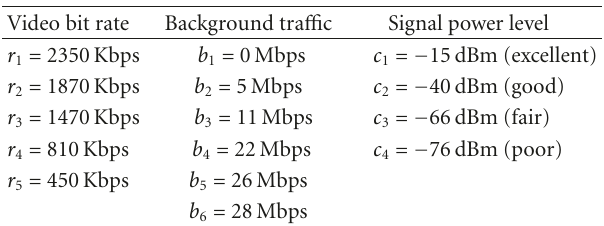
Table 4: Network parameters for the training phase. Video bit rate